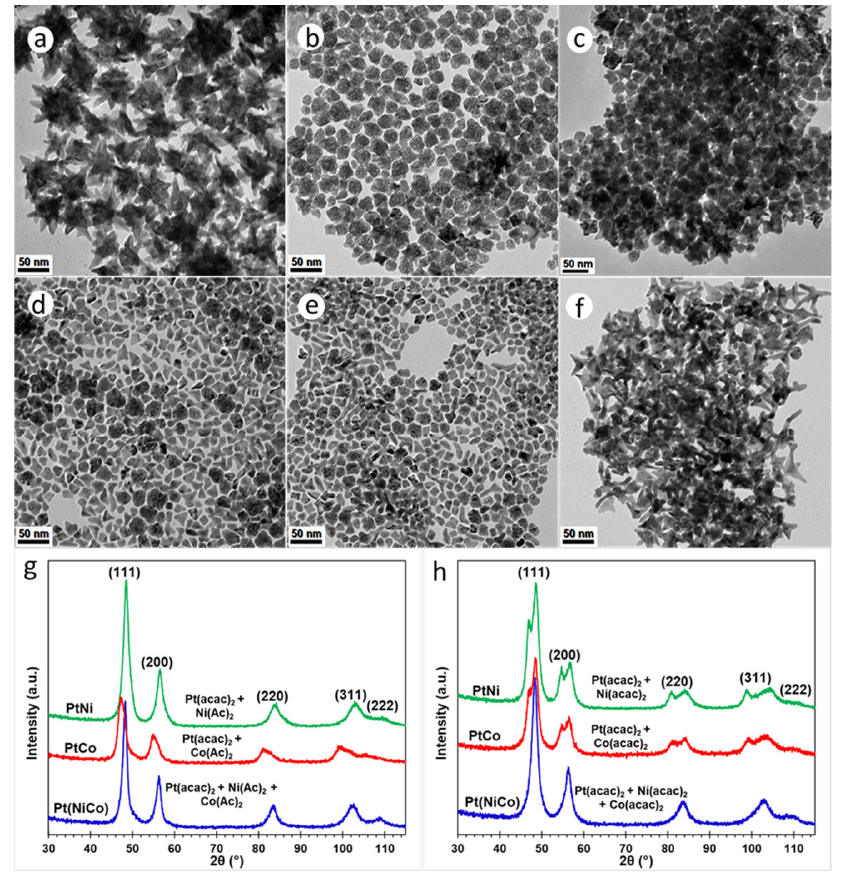
Figure 6. TEM BF images of PtNi, PtCo and Pt(NiCo) alloy NPs solution-grown via thermolytic decomposition of Pt(acac) 2 with ( a ) Ni(Ac) 2 , ( b ) Co(Ac) 2 and ( c ) Ni(Ac) 2 + Co(Ac) 2 ; ( d ) Ni(acac) 2 , ( e ) Co(acac) 2 and ( f ) Ni(acac) 2 + Co(acac) 2 in amine OAm as the sole surfactant. ( g ) are the corresponding PXRD patterns of these PtNi, PtCo and Pt(NiCo) alloy NPs displayed single solid solution phases. ( h ) are PXRD patterns of Pt(NiCo) NPs showing diffraction lines of a single disordered solid solution whereas both PtNi and PtCo NP systems displayed splitting of the diffraction lines, demonstrating the co-existence of two compositionally-distinct fcc phases.